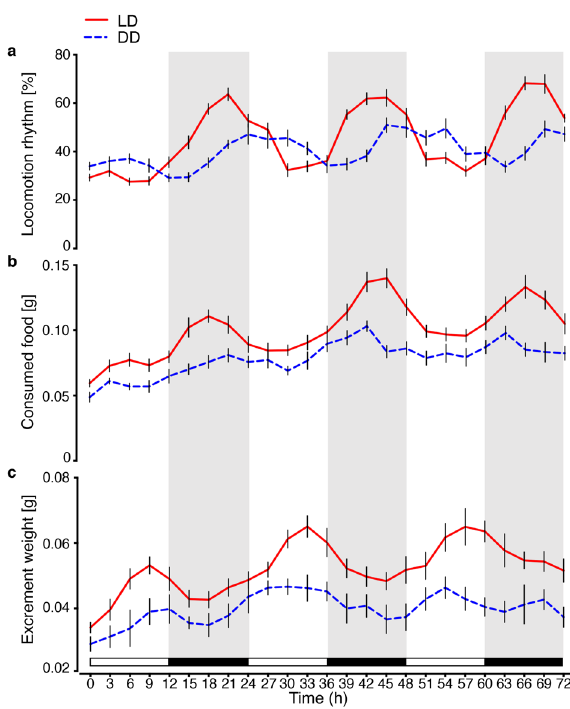
Fig. 1 Behavioral rhythms of S. litura larvae during 6LD1 to 6LD3. a Locomotion rhythm measured by recording the percentage of active larvae; b amount of consumed food; and c excrement weight under LD 12:12 (red solid line) and DD (blue dashed line) conditions. Nine groups each with 10 individuals were used for feeding behavior statistics. Counts were made for 6LD1-6LD3 larvae at 3 h intervals. Locomotion activity rhythm was measured according to the percentage of “ active ” larvae (see Methods); larvae were observed every 20 min, for a total of 9 values obtained at 3 h intervals. White and black shading indicates the photophase and scotophase. Error bars represent